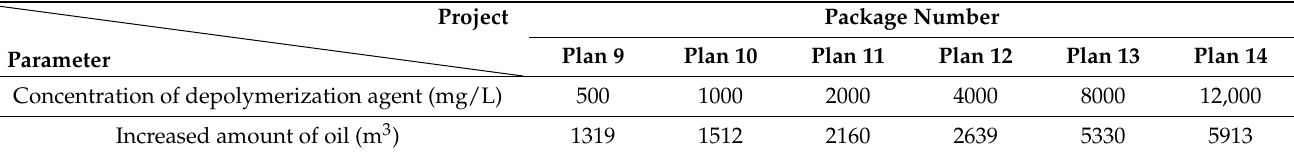
Table 9. Relationship between depolymerization agent concentration and oil